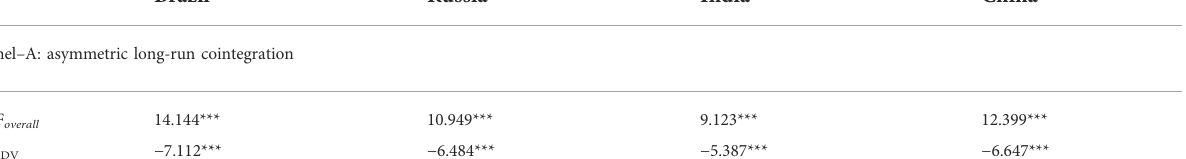
TABLE 7 Results of nonlinear ARDL